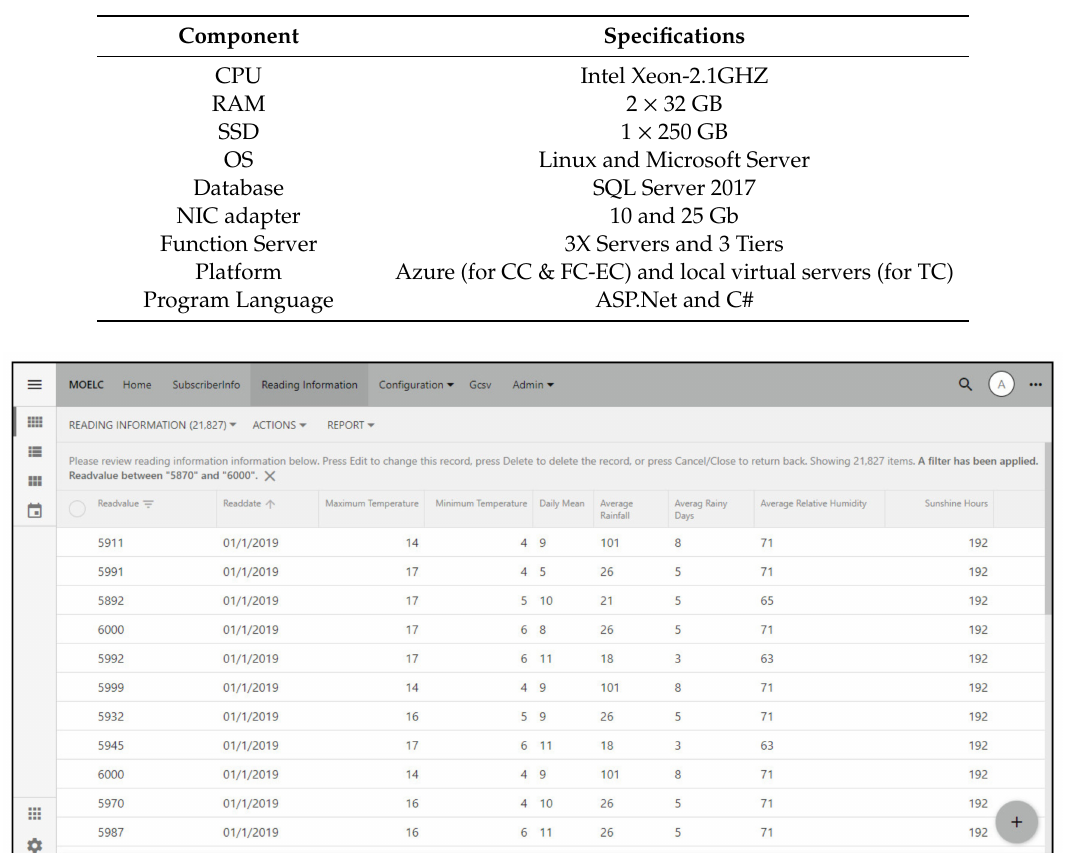
Table 5. Lab configuration setting for all scenario models (CC, FC-EC and TC SG).